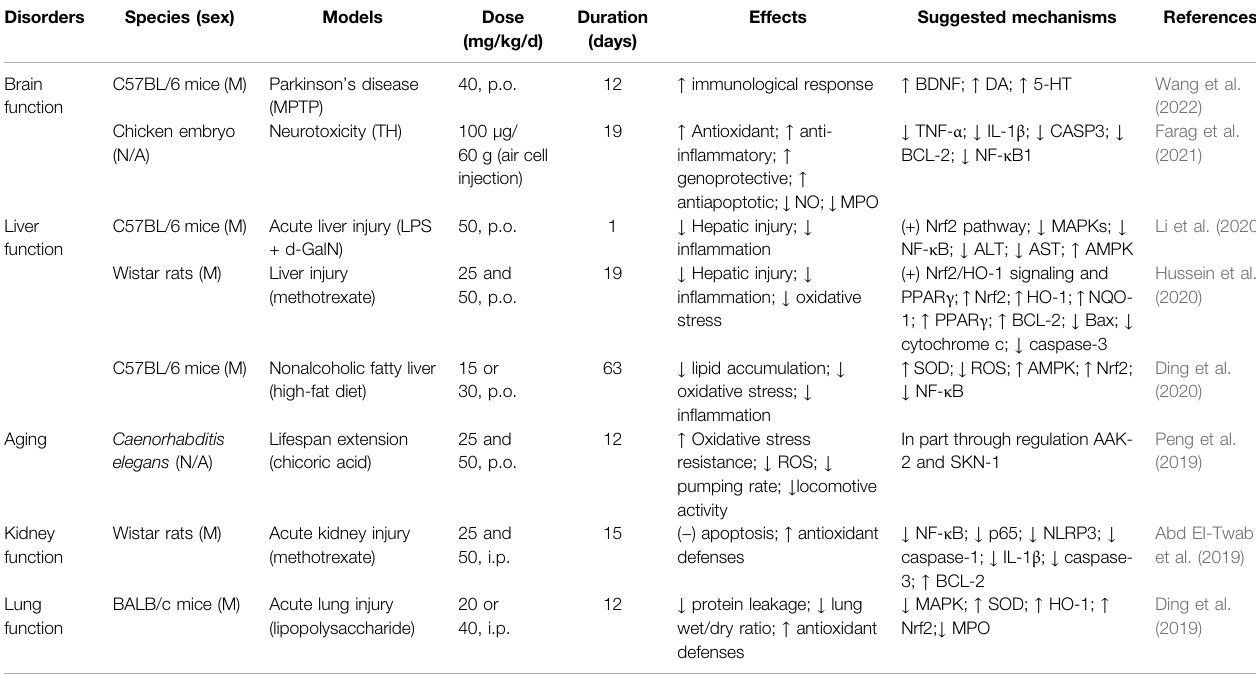
TABLE 5 | In vivo e ffects of chicoric acid in the treatment of various